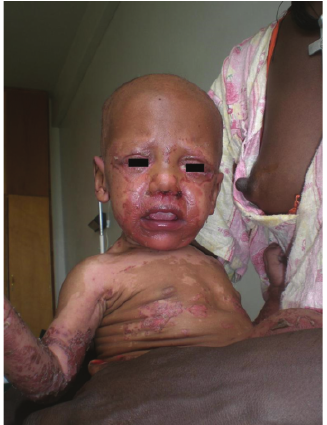
Figure 1: Periorificial lesions on face in an extensive case.